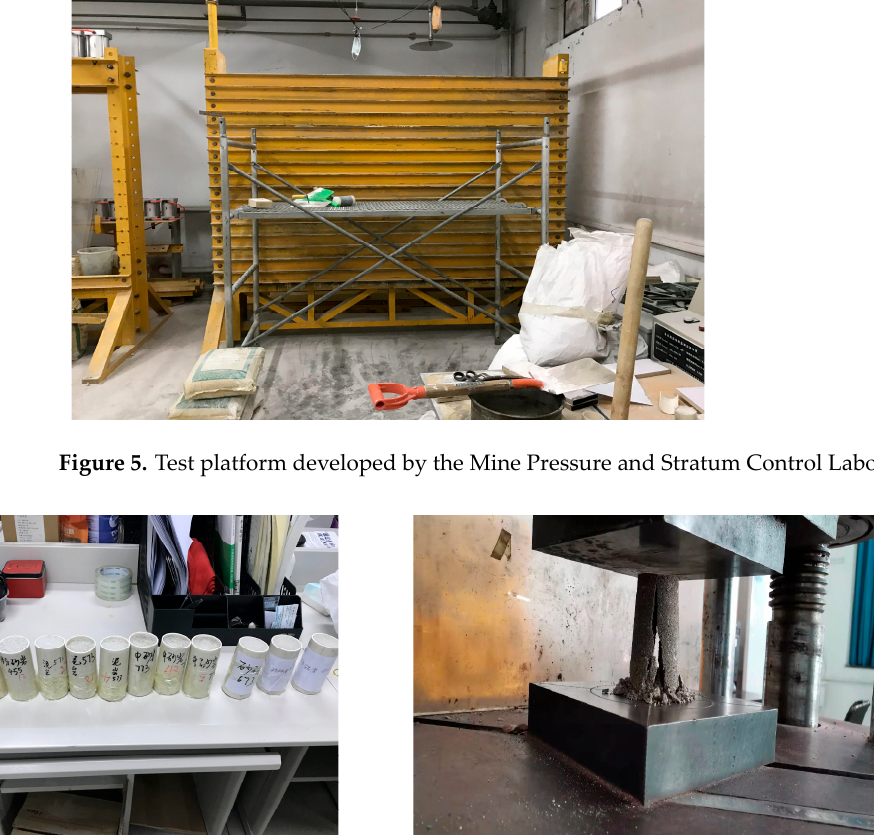
Figure 5. Test platform developed by the Mine Pressure and Stratum Control Laboratory.